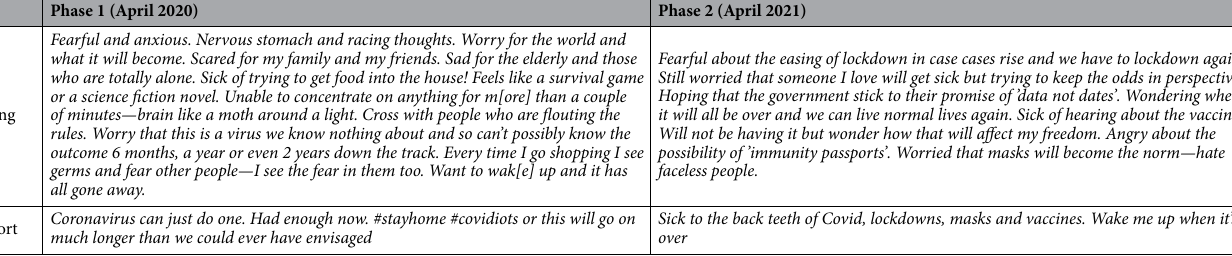
Table 1. Excerpts from both data collection phases (long and short